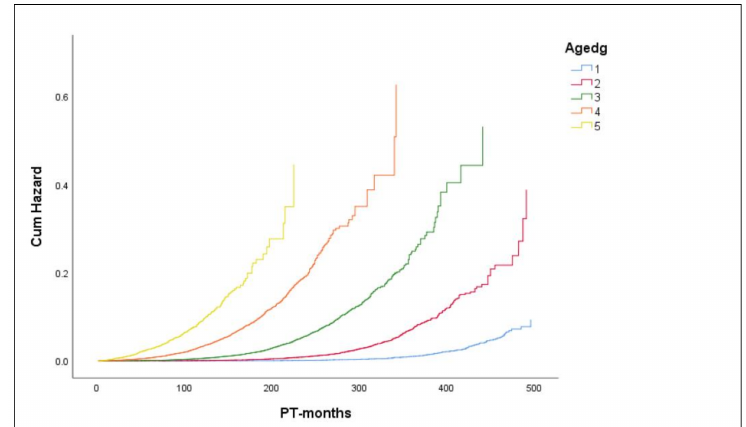
Figure 2. Baseline cumulative hazards of death from AD in patients diagnosed with breast cancer (BC). Data are shown for di ff erent time intervals after cancer diagnosis (PT-months), stratified by 5-year age groups at cancer diagnosis (Agedg) as follows: 1 (45–54 years), 2 (55–64 years), 3 (65–74 years), 4 (75–84 years) and 5 (85 +